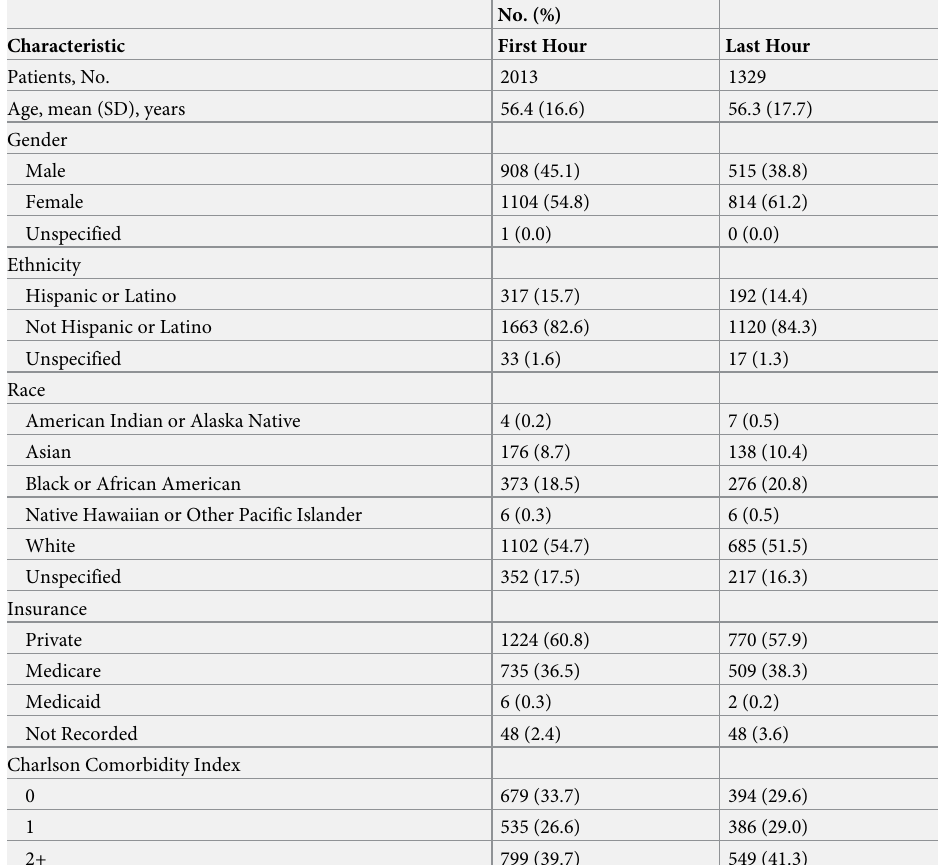
Table 1. Sample demographics of